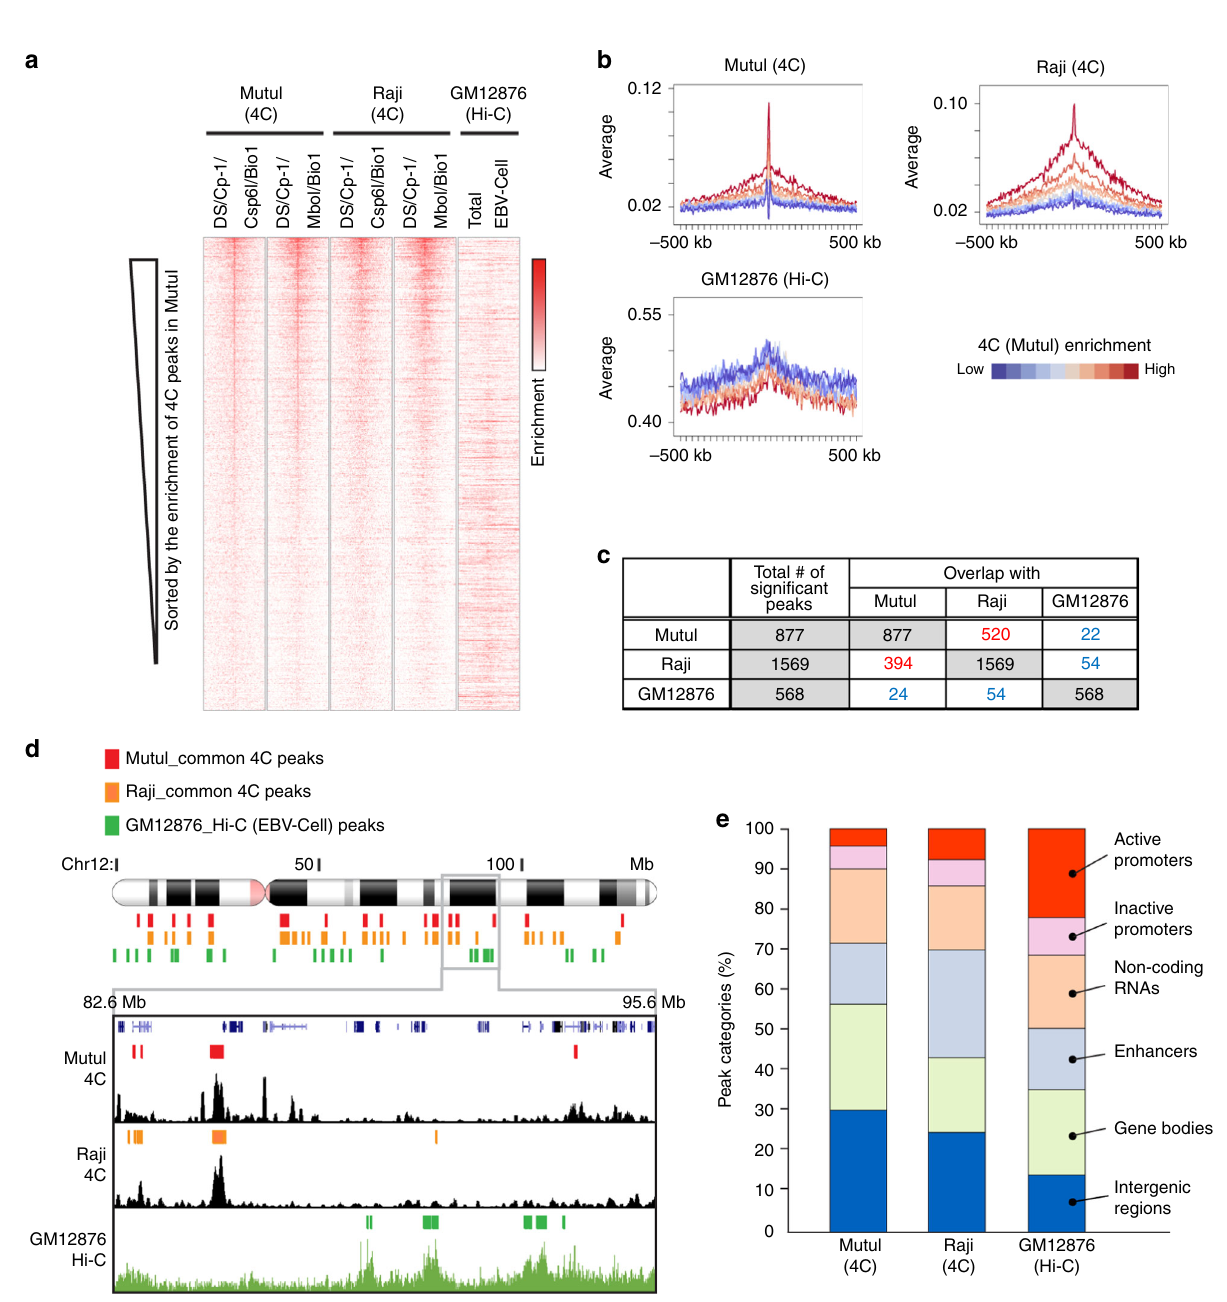
Fig. 4 Differences between LCL and BL cell tethering sites. a Heatmap comparison of 4C in MutuI and Raji (DS/Cp-1/Csp6I/MboI) with Hi-C in GM12878. b Average enrichment of 4C peaks (DS/Cp-1/Csp6I) in MutuI and Raji and Hi-C peaks in GM12878 shown in panel a . The average enrichments are classi fi ed into 10 groups based on the 4C (MutuI/DS/Cp-1/Csp6I) scores (top: red → bottom: blue). c Table showing the number of overlapped peaks among MutuI (4C), Raji (4C), and GM12878 (Hi-C). d Example of 4C peaks for MutuI (DS/Cp-1/Csp6I/Bio1), Raji (DS/Cp-1/Csp6I/Bio1), and Hi-C peaks for GM12878 at the chr12: 82.6 – 95.6 Mb regions. e Distribution of EBV associating genomic loci at the indicated genetic